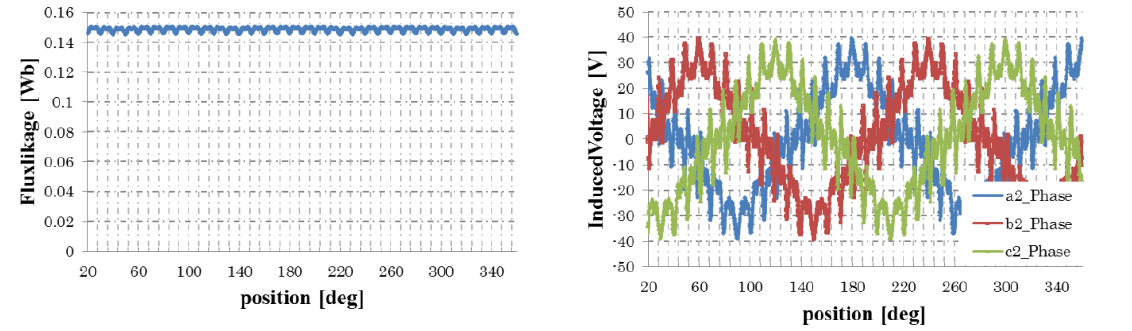
Figure 6. Flux linkage and induced voltage under DC current excitation. ( a ) Flux linkage; ( b ) induced